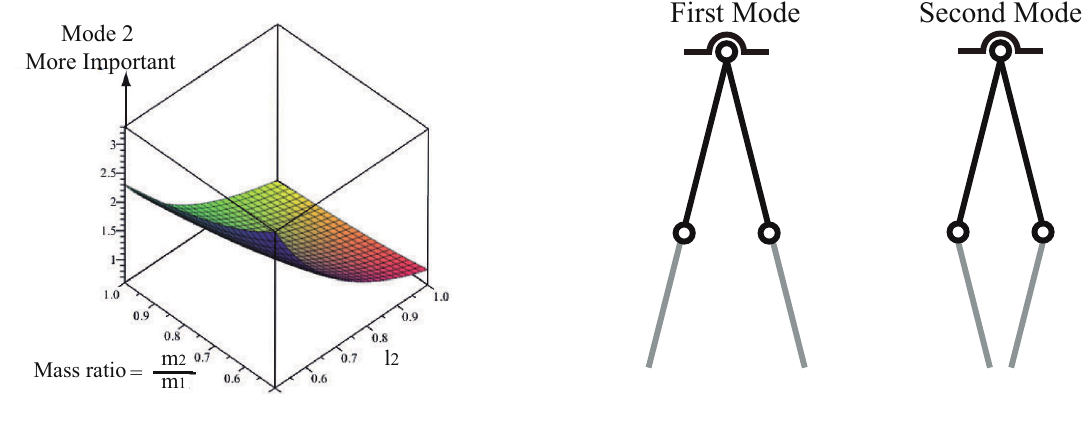
Figure 12. Mode Ratio High Mode to Low Mode amplitude. Conditions 0.5 < l 2 < 1 and 0.5 < R <